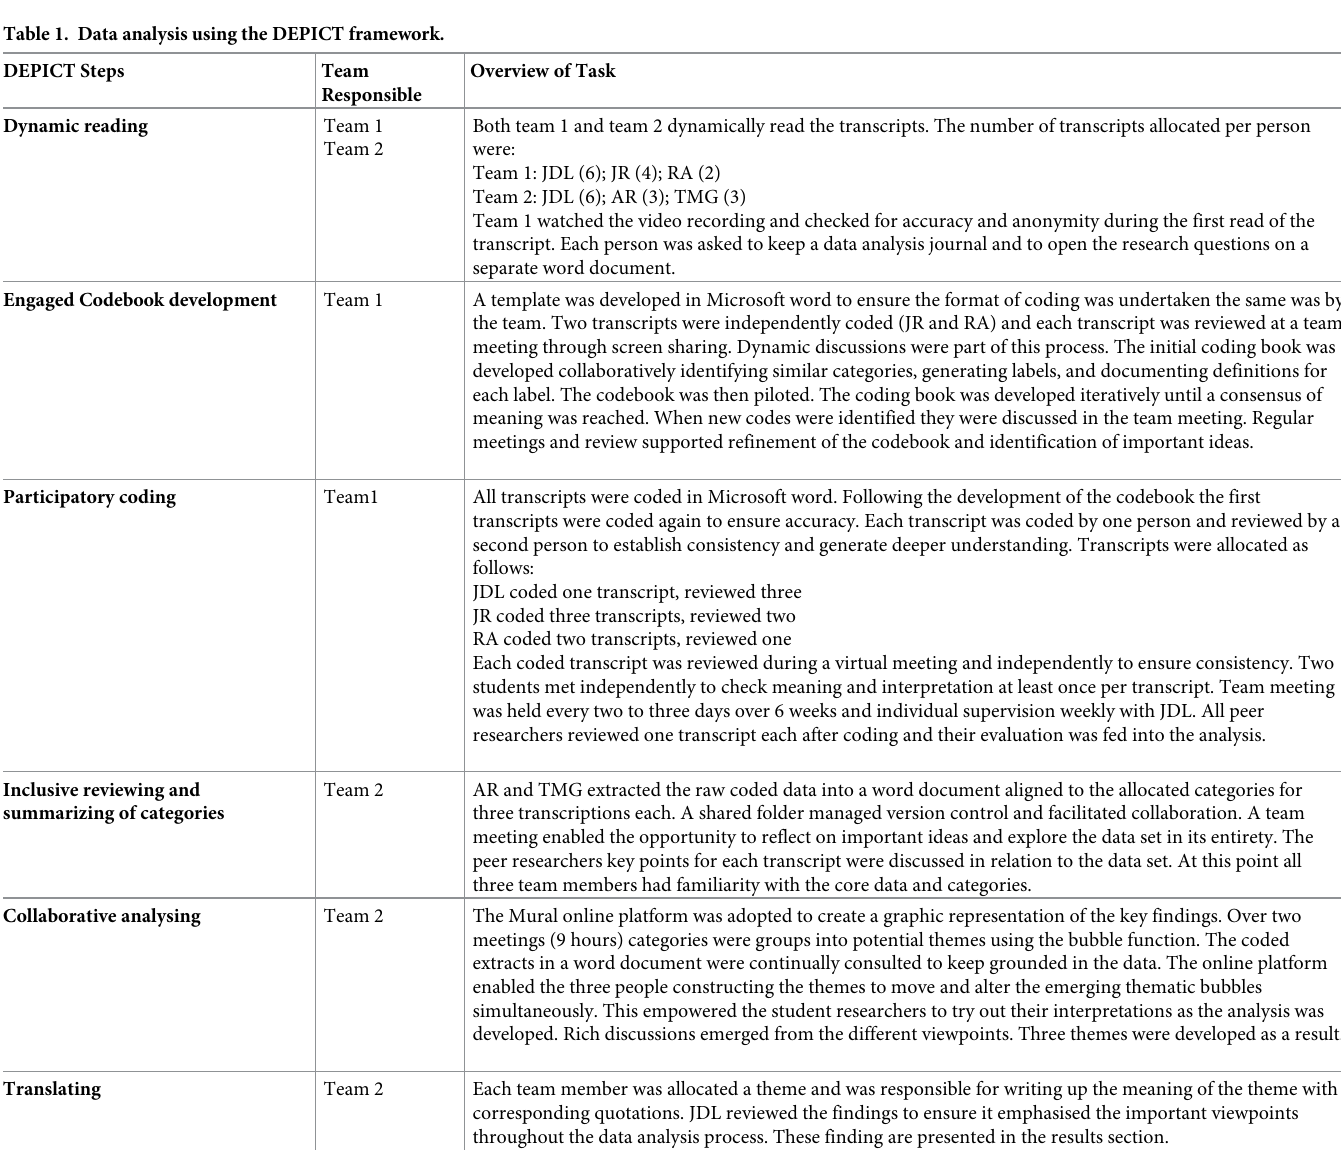
Table 1. Data analysis using the DEPICT